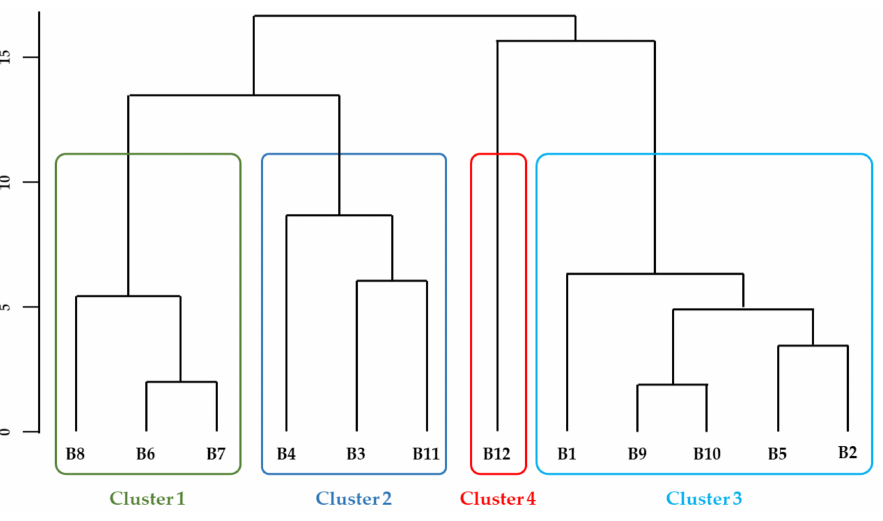
Figure 5. Dendrogram of cluster analysis of broas . Table 4. Broas ’ volatile compounds that contributed to discriminate the different